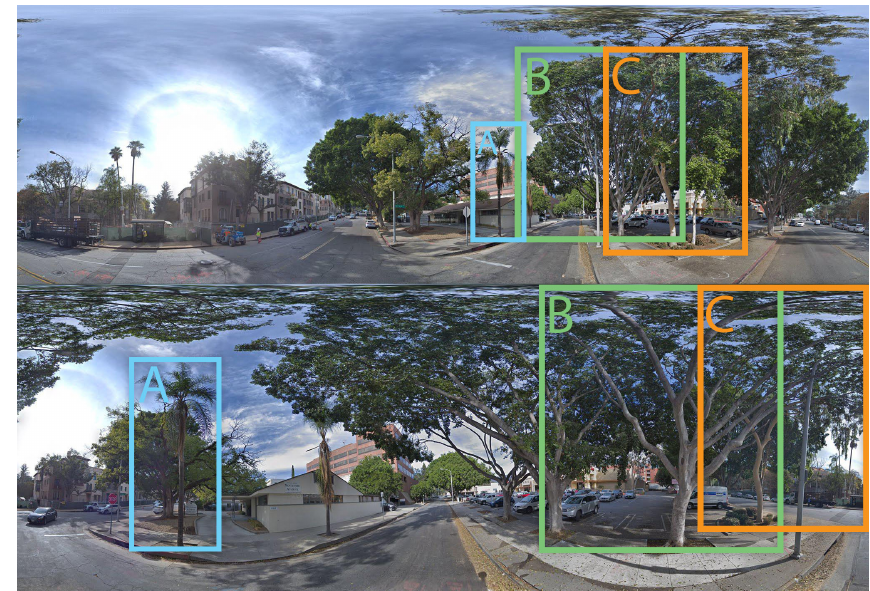
Figure 2. The tree instance matching problem (color and letters indicate the matches of identity): each tree is photographed from multiple different views, changing its size, perspective, and background. Note that many trees look alike and are in close proximity (Imagery c (cid:13) 2019